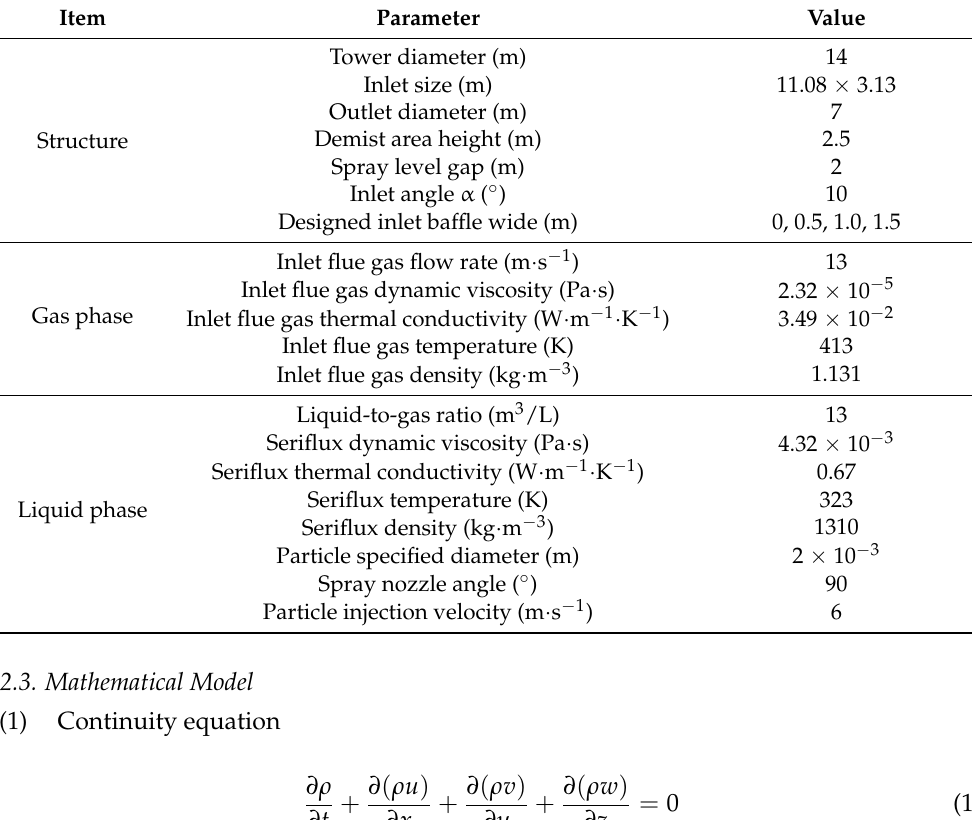
Table 1. Basic parameters of the numerical simulation. Item Parameter Value